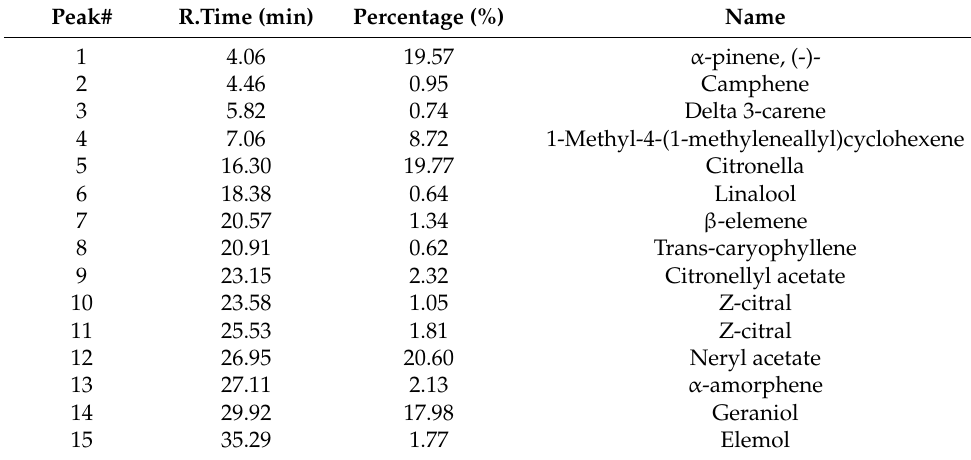
Figure 2. GC–MS chromatogram of citronella oil. Table 1. List of identified chemical compounds in citronella oil.